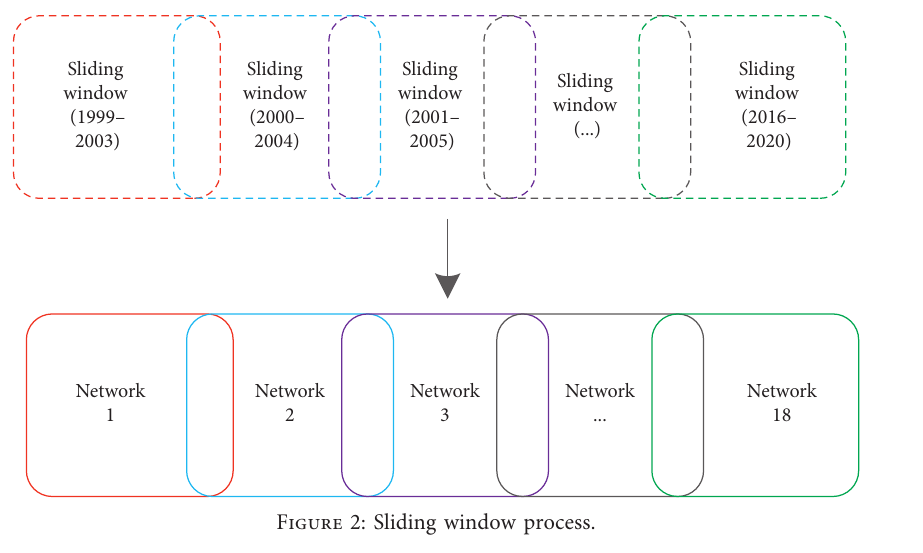
Figure 2: Sliding window